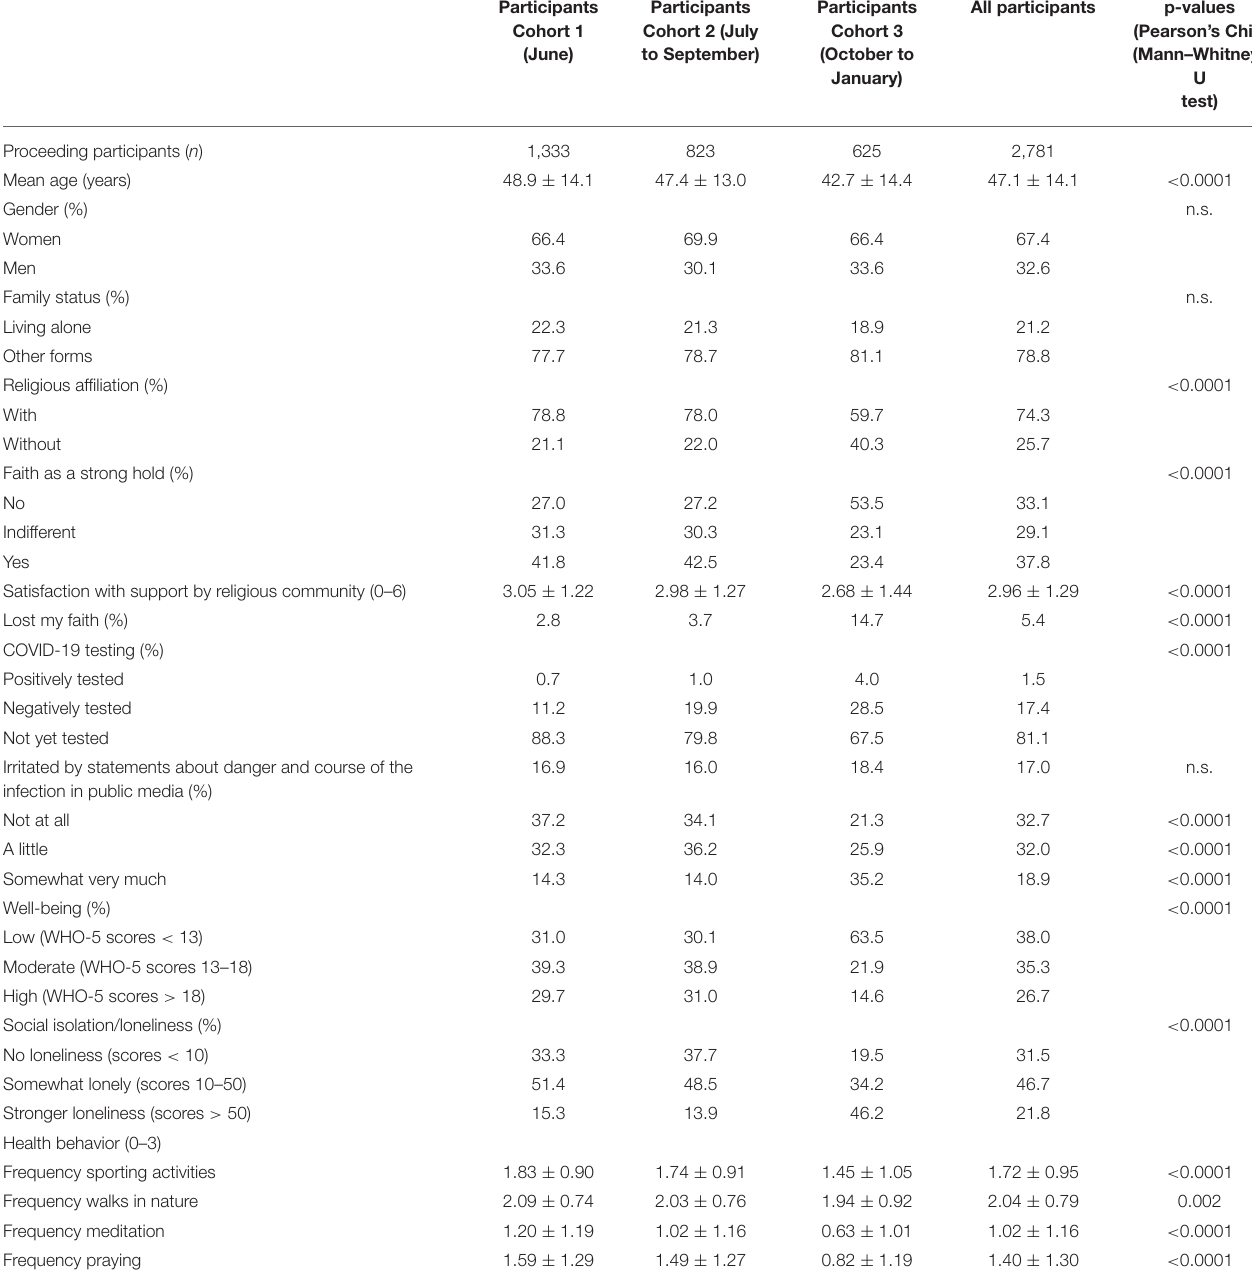
TABLE 1 | Description of the samples ( N =